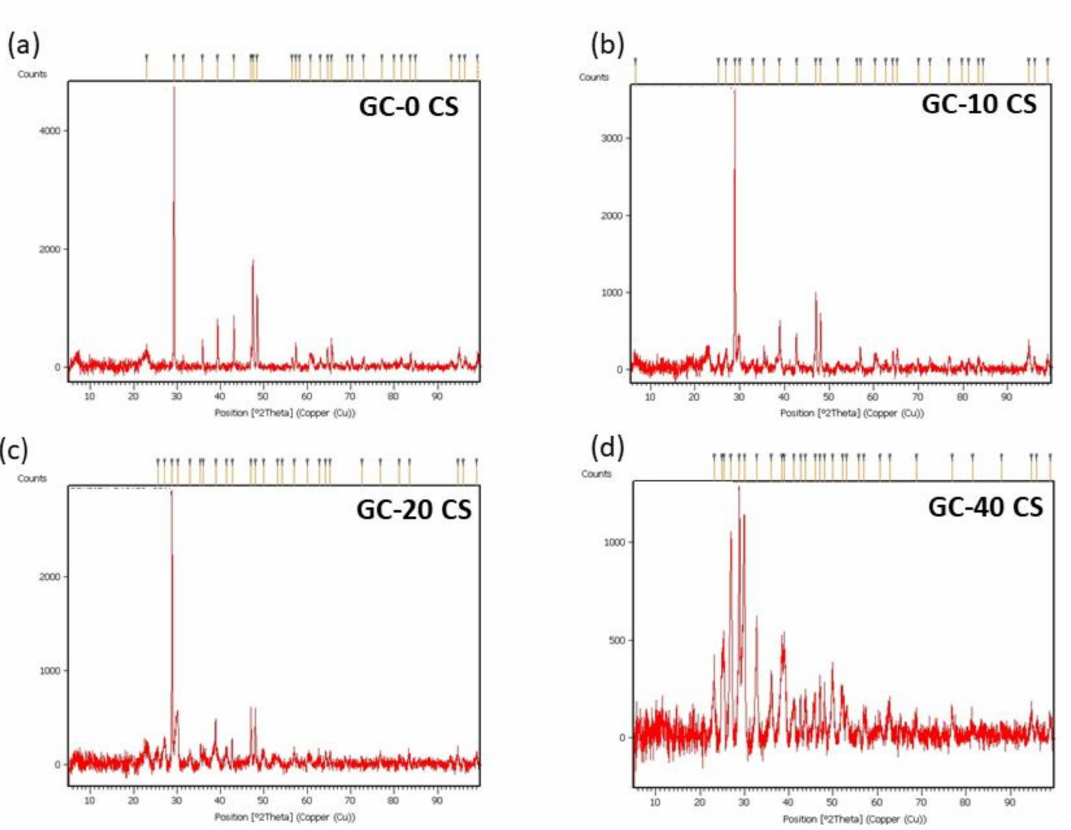
Figure 3. XRD spectra: ( a ) GC-0 CS, ( b ) GC-10 CS, ( c ) GC-20 CS, and ( d ) GC-40 CS scaffolds. The two axes are the position (2 θ ◦ -copper) and the counts indicated in the data. Table 2. Analysis of BET for calcium-silicate reinforced Gellan-chitosan scaffold. S.